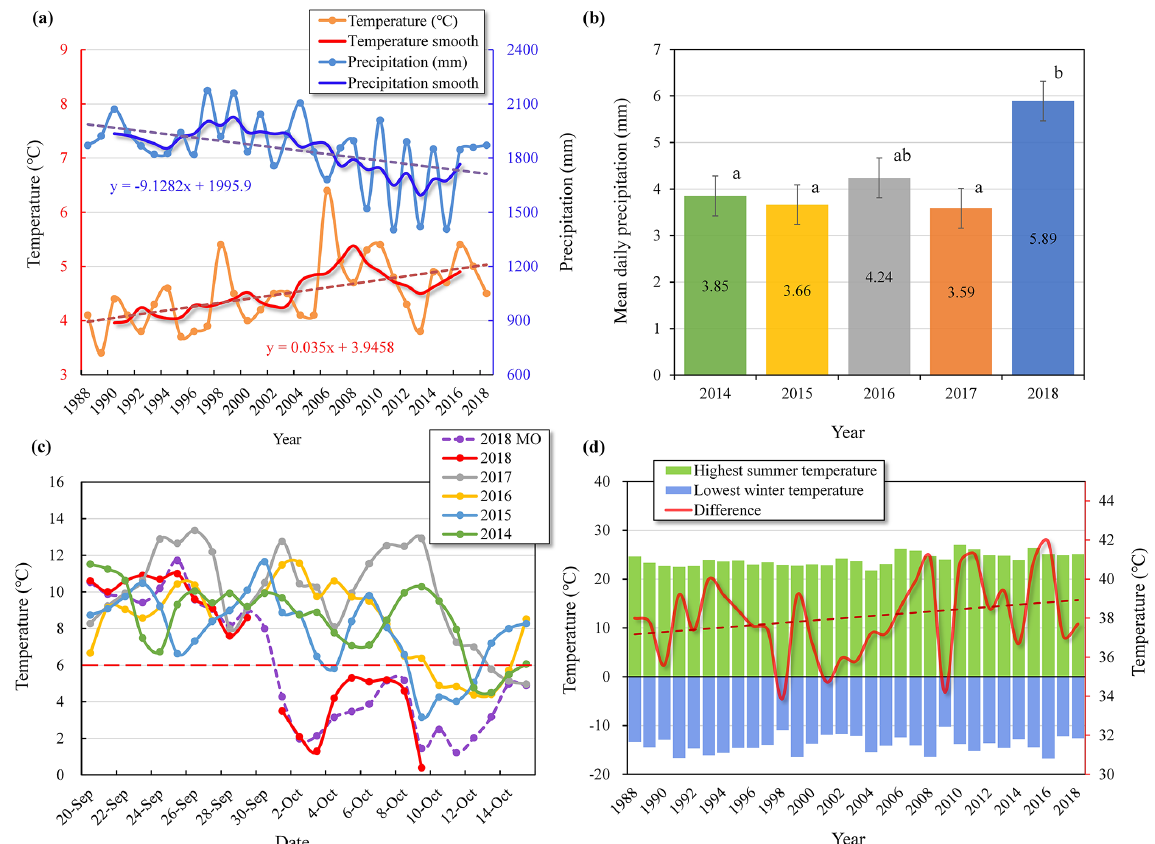
Figure 6. Meteorological data. (a) Mean annual air temperature (orange) and annual precipitation (blue) were recorded at the 3000m station. The temperature data for 2017 are from manual observations. Between 1990 and 2016, the moving average for temperature and precipitation has been calculated. (b) Differences in the mean daily precipitation between 5–20 October 2018 and 5–20 October 2014–2017. Analysis of variance (ANOVA) was used to investigate the difference of mean daily precipitation between 5 years; it found that mean daily precipitation in 2018 was significantly higher than that in 2014, 2015, and 2017 ( p< 0 . 05). (c) Differences in the daily mean temperature between September–October 2018 and September–October 2014–2017; MO indicates manual observation. (d) The average of the highest summer temperature (green bar) and lowest winter temperature (blue bar) of each year, and their differences (red